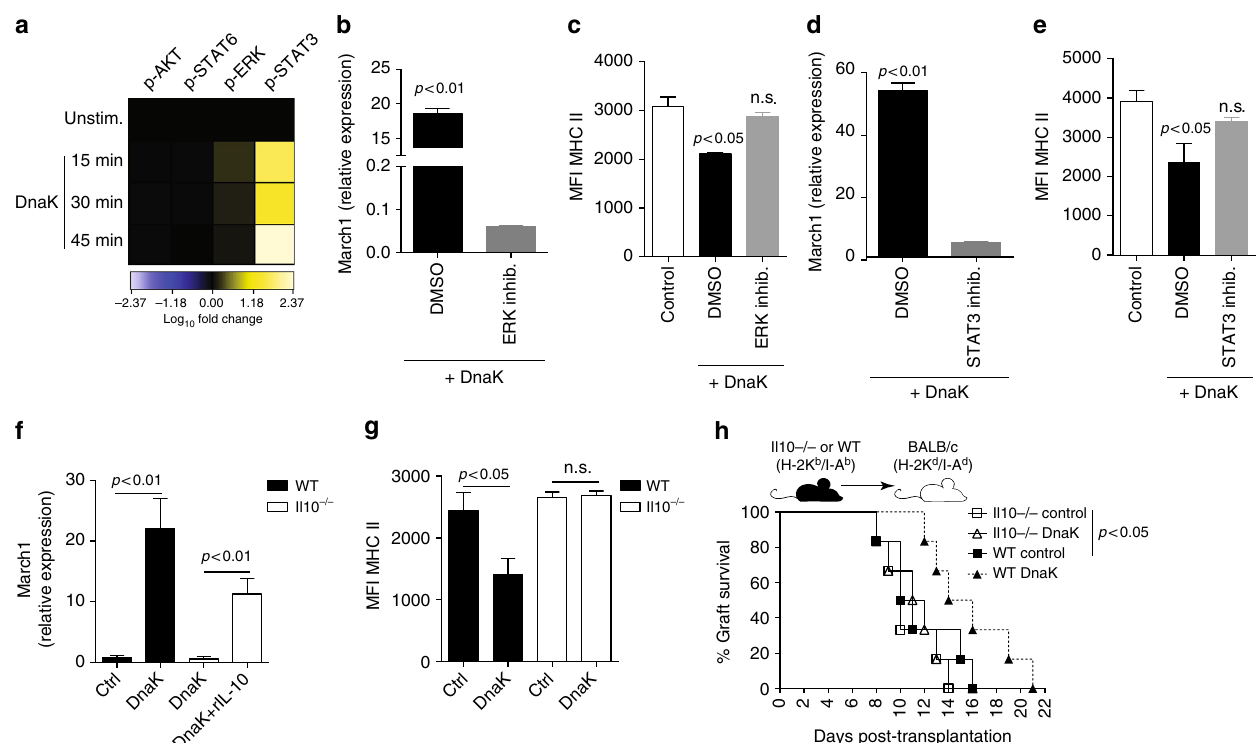
Fig. 5 March1 induction by DnaK requires ERK, STAT3 and IL-10. a BioHeat map representing the fold change of p-Akt (pS473), p-STAT6 (pY641), p-ERK1/ 2 (pT202/pY204), and p-STAT3 (pY705) in the BMDCs treated with DnaK for 15, 30, and 45 min, compared to untreated ones. March1 mRNA levels and MHC II levels by fl ow cytometry on WT LN DCs treated with b , c ERK inhibitor (PD98059) or d , e STAT3 inhibitor (BP-1-102) and stimulated with DnaK. f March1 expression in WT or Il10 − / − LN-derived DCs treated with DnaK, medium or DnaK + recombinant murine IL-10. Actb was used as internal control for real-time PCR analysis. g MHC II levels on WT or Il10 − / − DnaK- or control-treated DCs. Statistics using ANOVA with Tukey post-test ( n = 3 mice